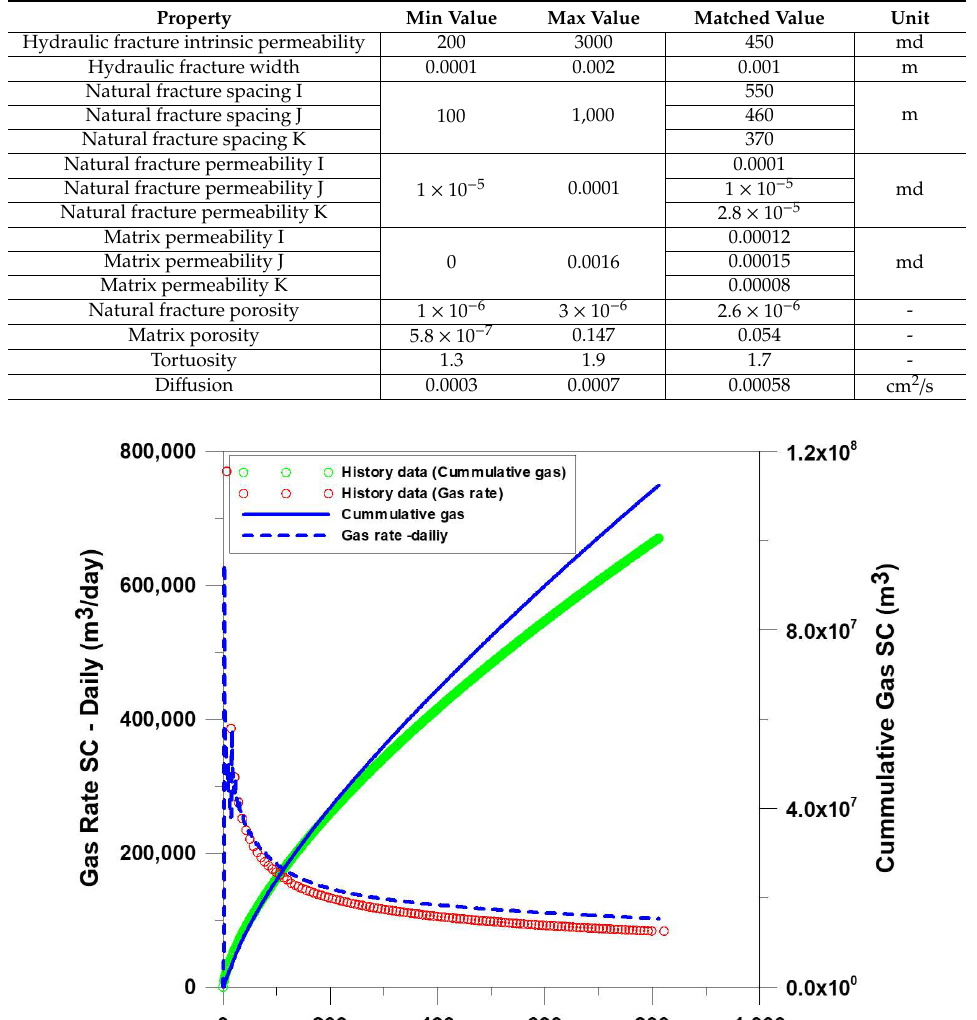
Table 3. Parameter values of matched model.